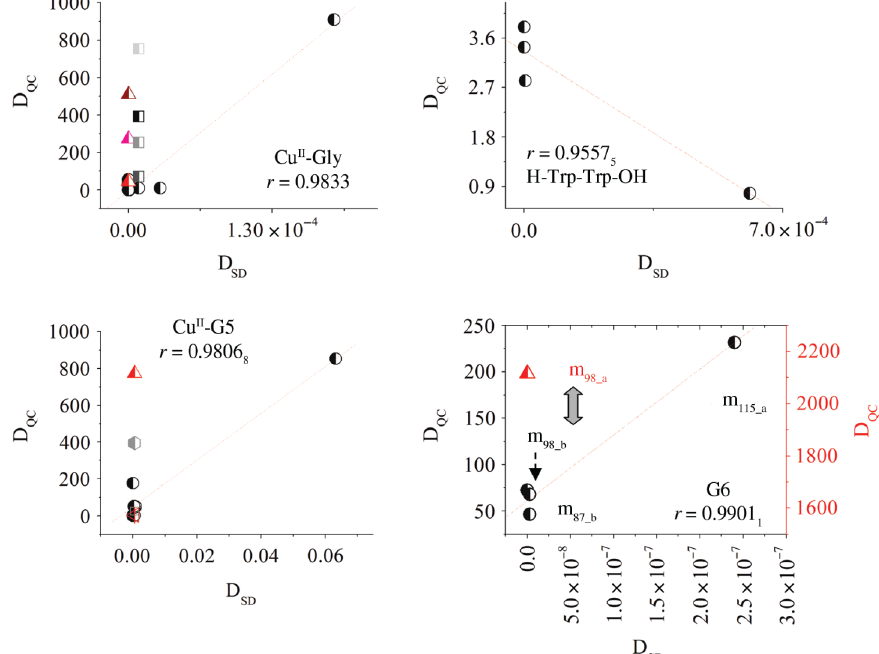
Figure 1: Quantitative linear correlations between the diffusion parameters D oligopeptides and their metal organics and those obtained based on the Arrhenius ’ s approximation, respectively; chemo- metrics; statistical coefficient of linear correlation “ r ”